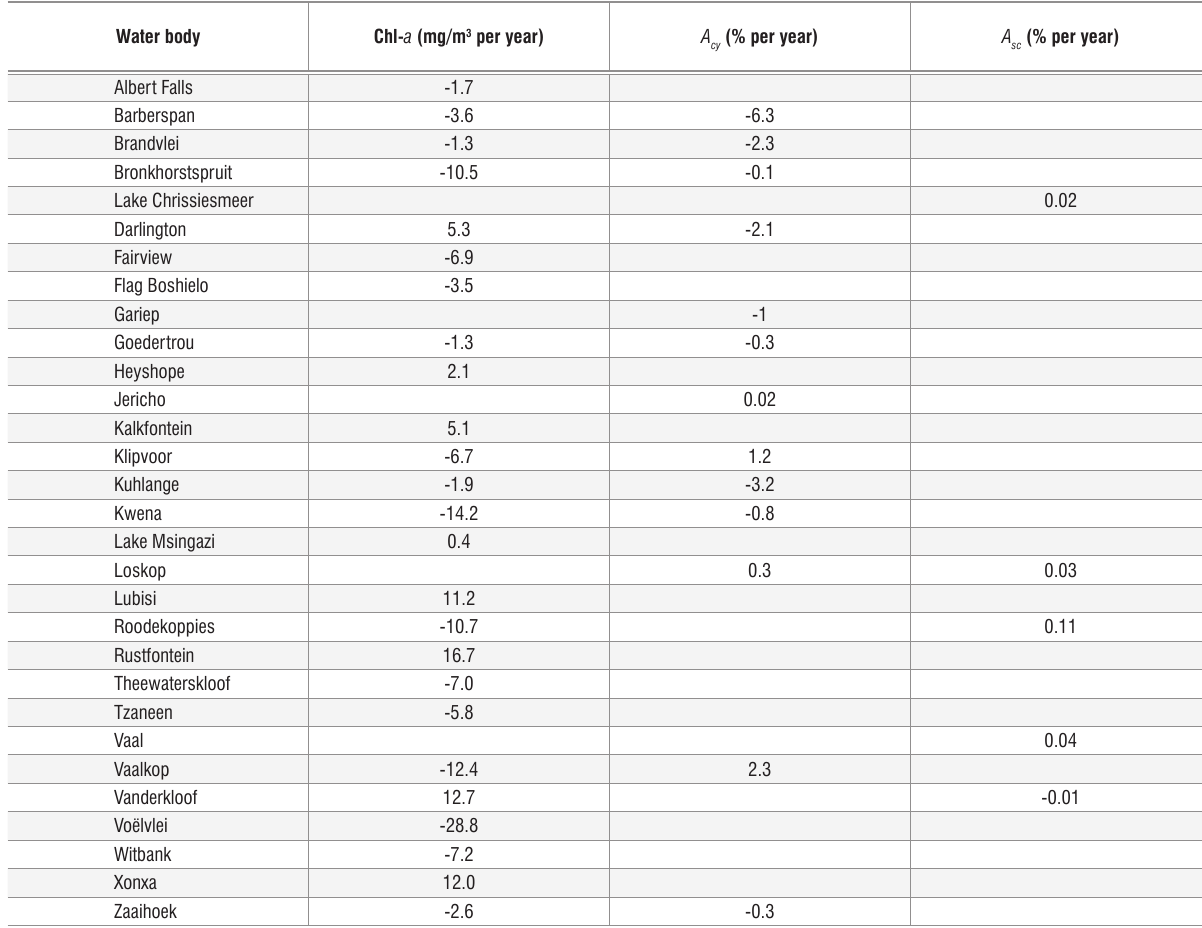
Trends significant at 95% confidence interval between 2005 and 2011. Empty entries were not significant. Preliminary results from highly turbid water bodies excluded.